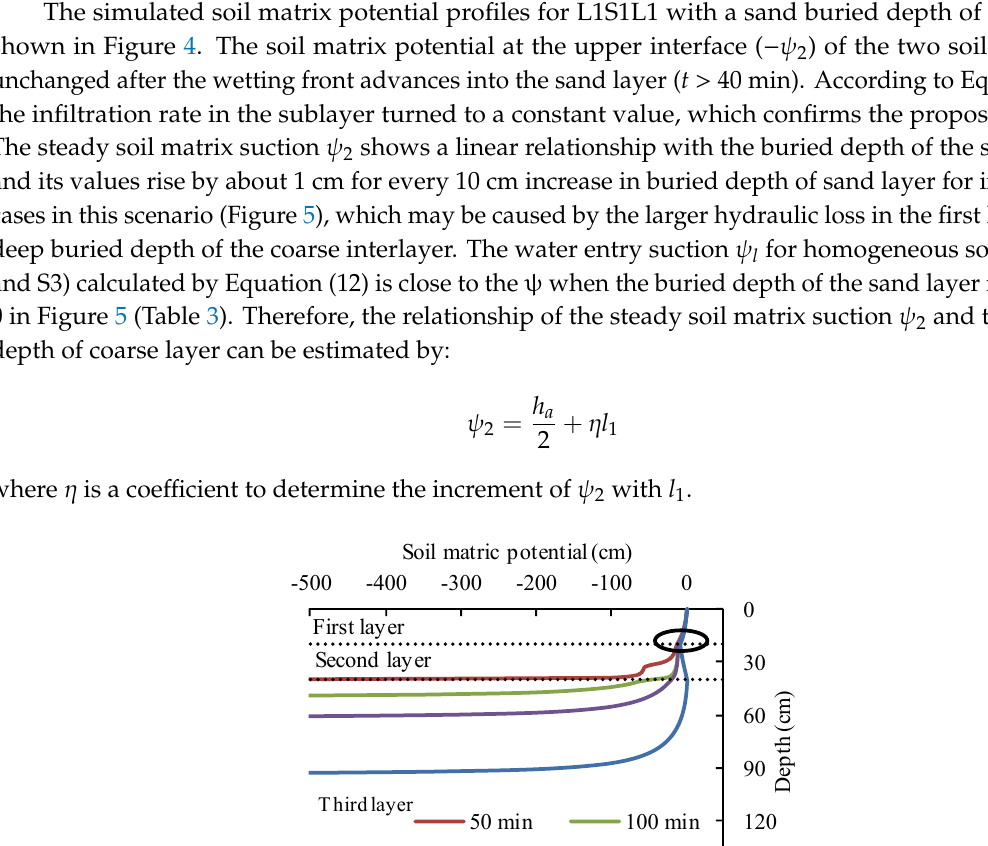
ff erent infiltration